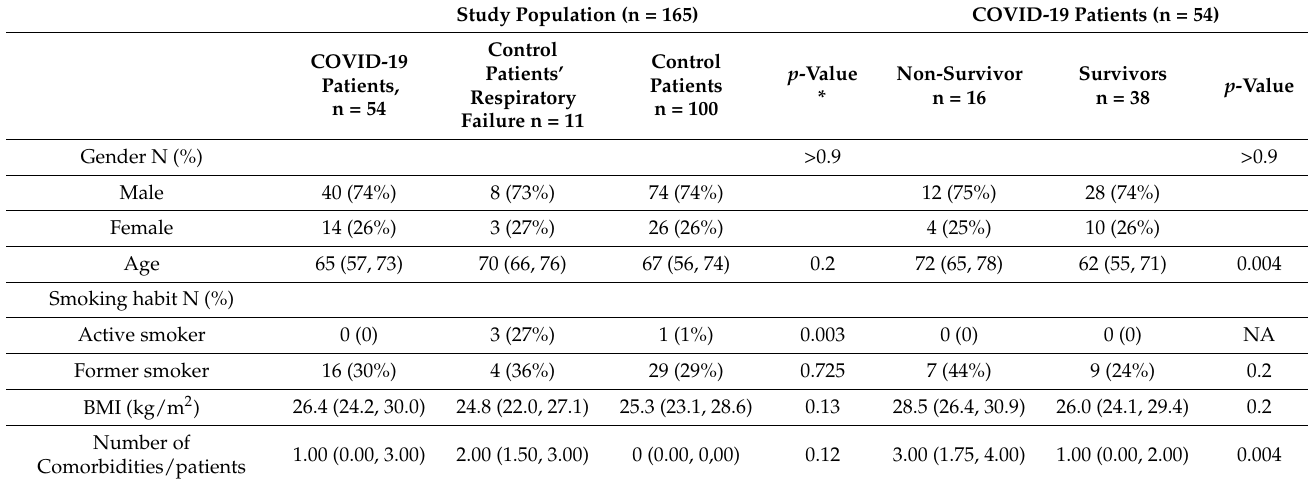
Table 1. Demographic and clinical characteristics of the study